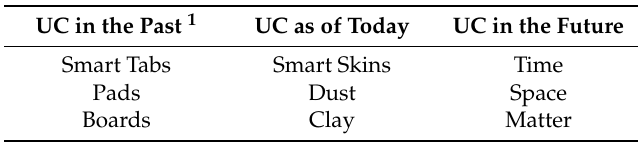
Table 2. Ubiqutous computing (UC)